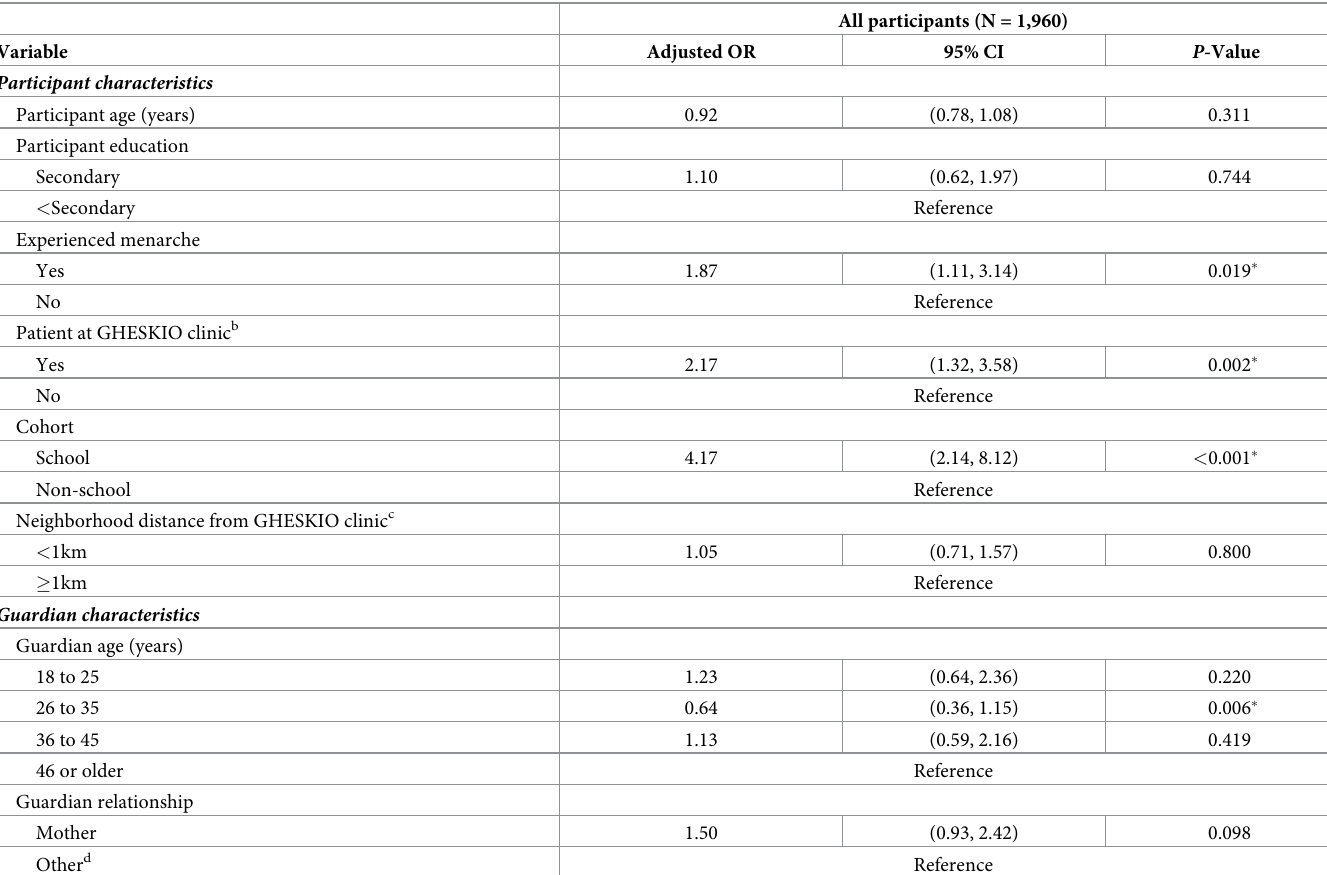
Table 2. Multivariable regression of completion of the vaccination series among participating adolescents who received at least 1 dose of HPV vaccination. a